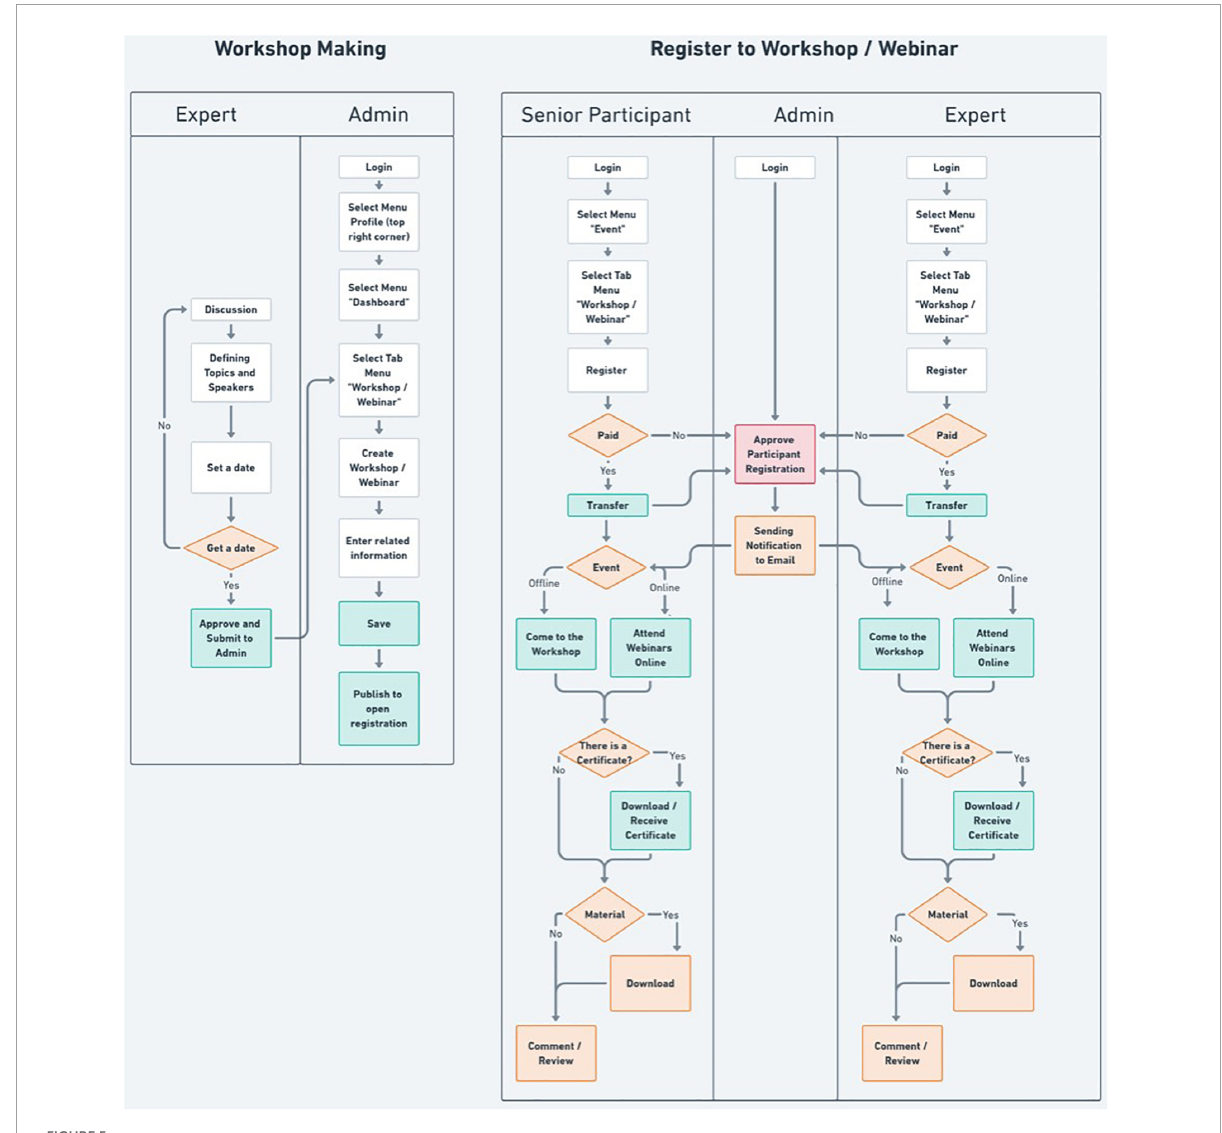
FIGURE5 Flow chart of workshop or webinar